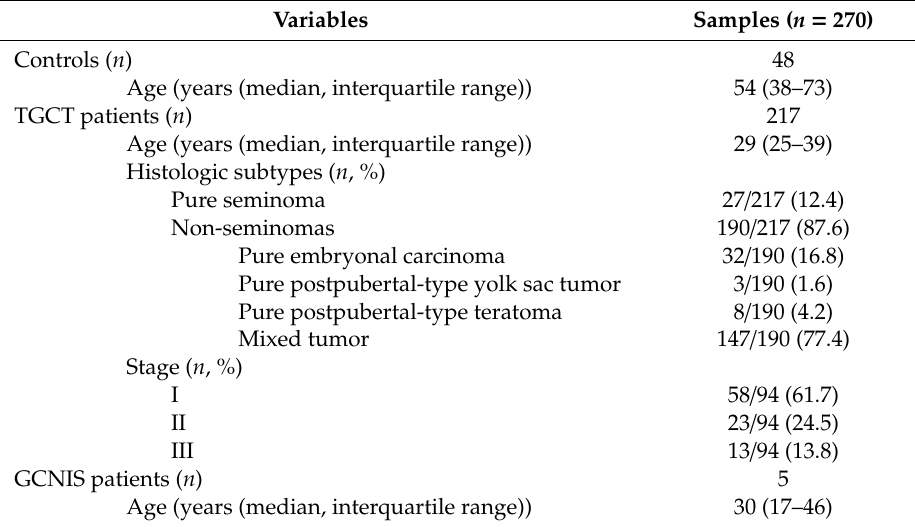
Table 5. Clinicopathological features of the serum